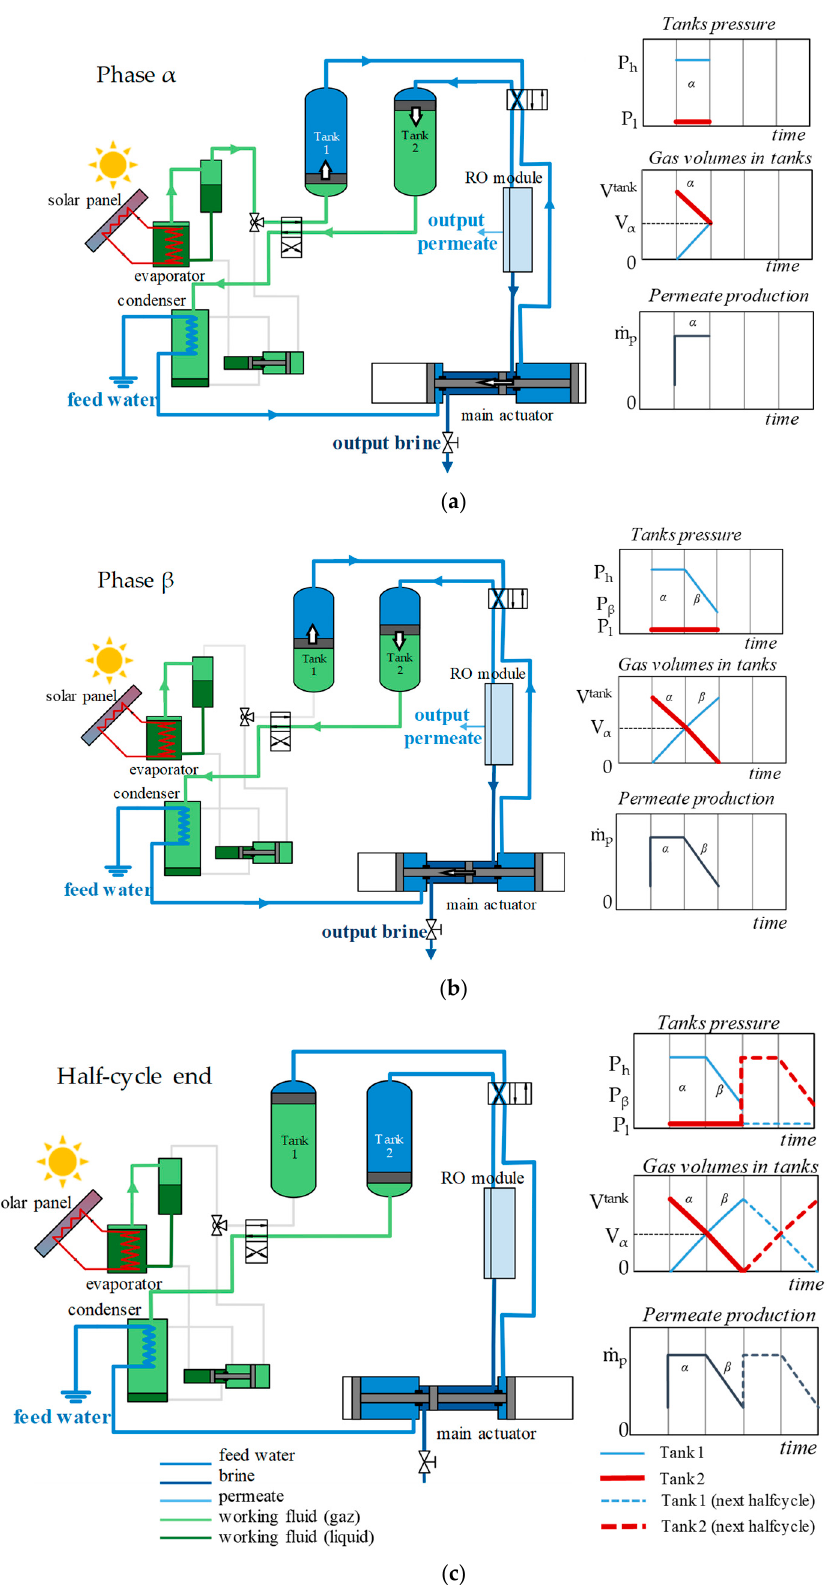
Figure 2. Flow diagram of the thermo-hydraulic desalination process during a half-cycle: ( a ) alpha phase, ( b ) beta phase, ( c ) end of half-cycle. Schematic representation of the evolution of the pressure and volume in the transfer tanks, and the mass flow rate of the permeate over one complete cycle.